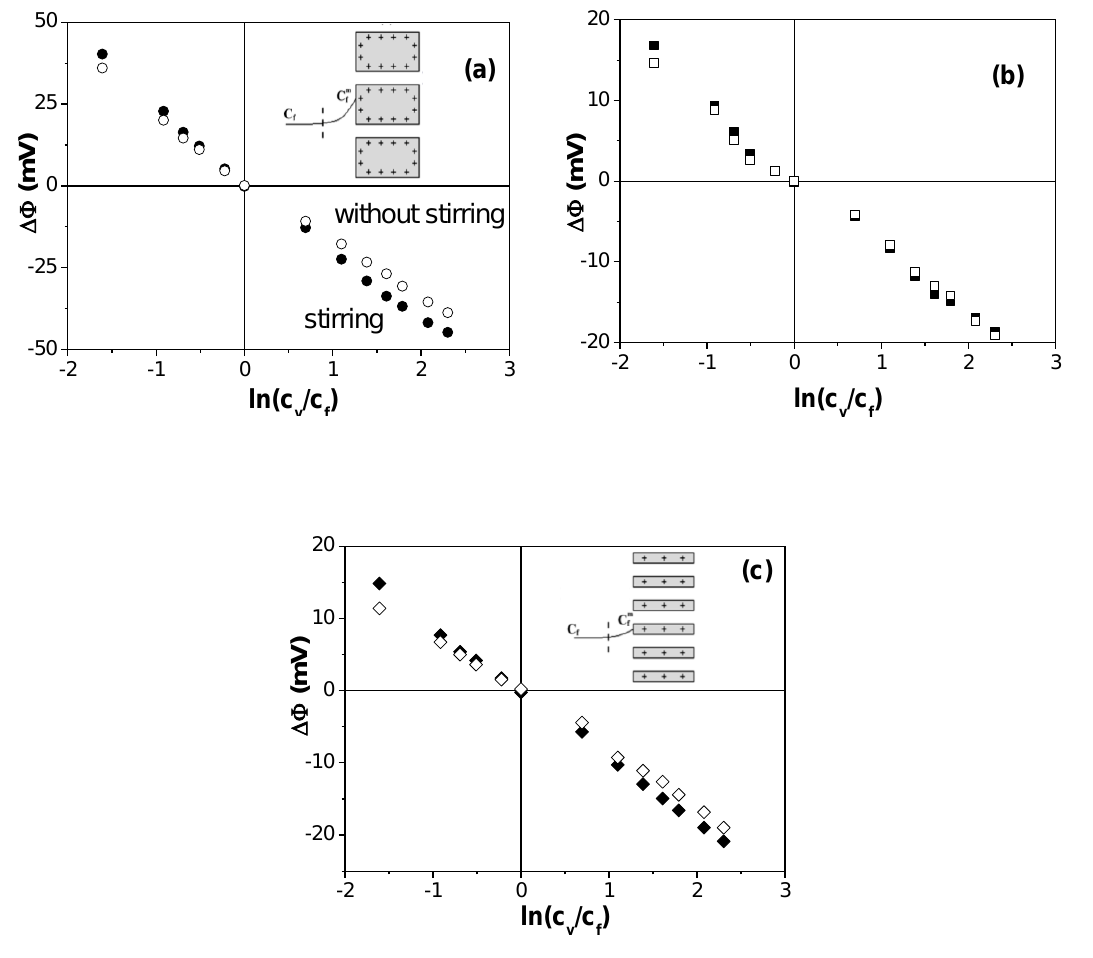
Figure 6. Effect of solution stirring on ΔΦ values. ( a ) NPAS-Sf: (●) solutions stirred, ( ○ ) solutions not Figure 6. E ff ect of solution stirring on ∆Φ values. ( a ) NPAS-Sf: ( • ) solutions stirred, ( stirred; ( b ) NPAS-Ph: ( (cid:4) ) solutions stirred, ( (cid:3) ) solutions not stirred; ( c ) NPAS-And: ( (cid:7) ) solutions stirred, stirred; ( b ) NPAS-Ph: ( ■ ) solutions stirred, ( □ ) solutions not stirred; ( c ) NPAS-And: ( ♦ ) solutions ( ♦ ) solutions not stirred. The inset shows possible concentration–polarization e ff stirred, ( ◊ ) solutions not stirred. The inset shows possible concentration–polarization effect.